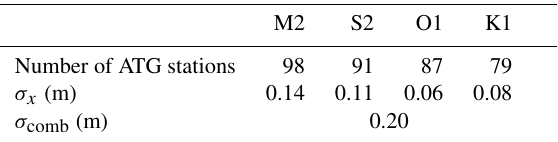
Table 2. Summary of tidal height comparison against Antarctic tide gauge records using root mean square differences (RMSDs). RMSD amplitude relative to ATG is also